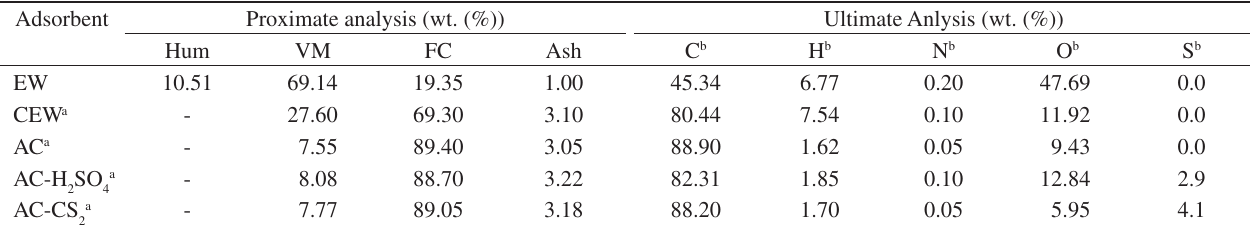
Table 1. Proximate and elemental analysis (expressed in a dry basis).